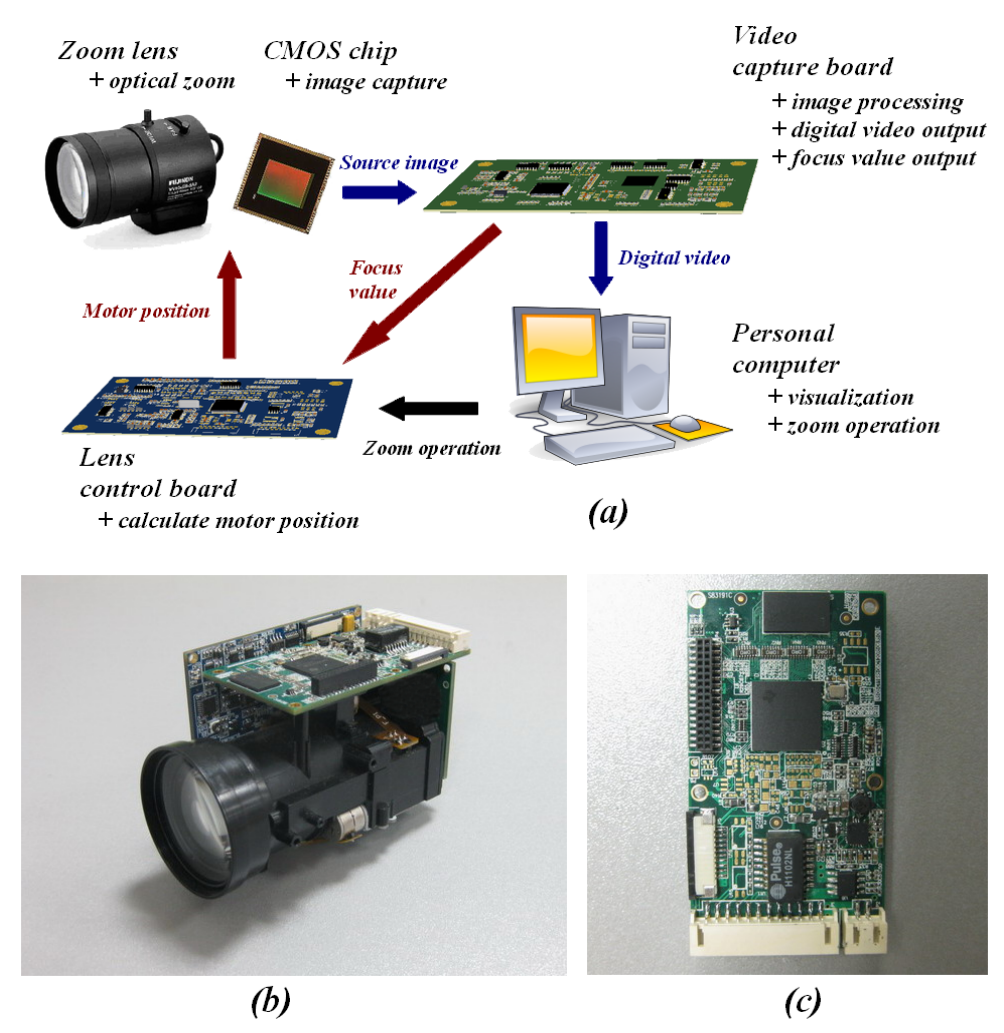
Figure 12. High-speed TI TMS320DM365 digital video